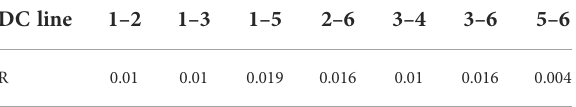
TABLE 4 Generator cost curves.